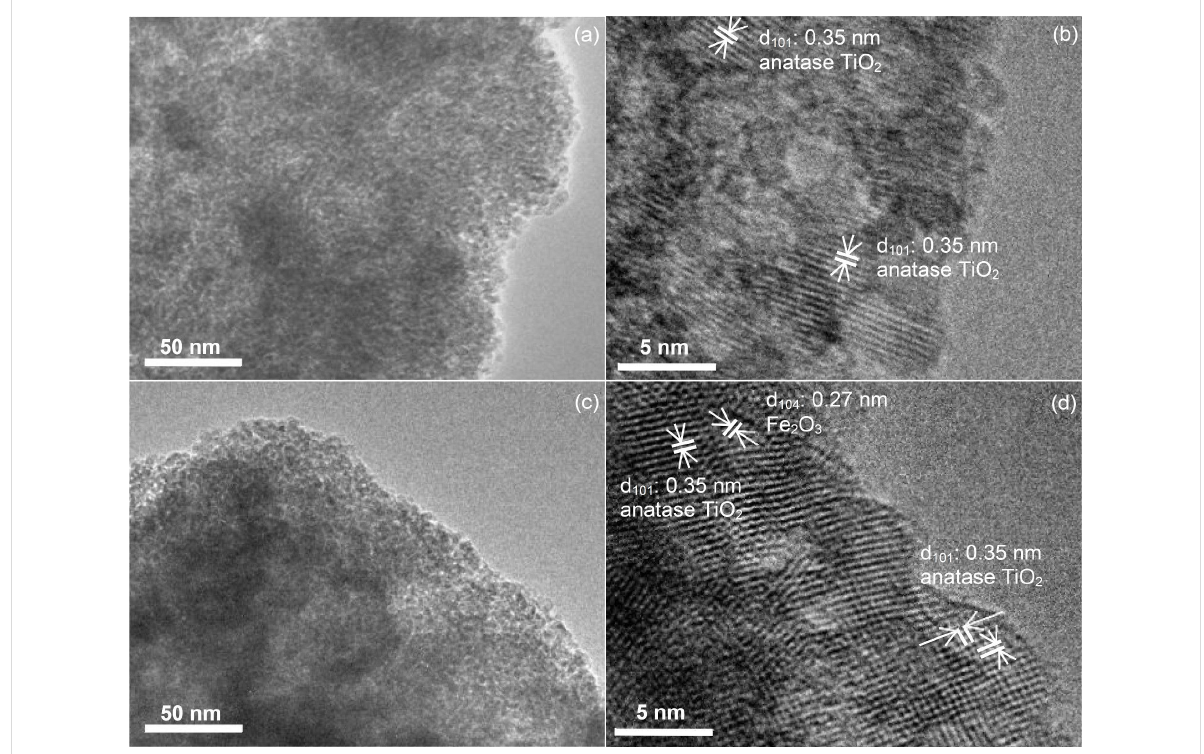
Figure 4: (a) TEM image of unmodified TiO 2 (NT) and (b) its respective HRTEM image, (c) TEM image of Fe 2 O 3 (0.5)/TiO 2 (PD) and (d) its respective HRTEM